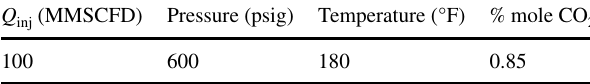
Table 2 Injection fluid properties